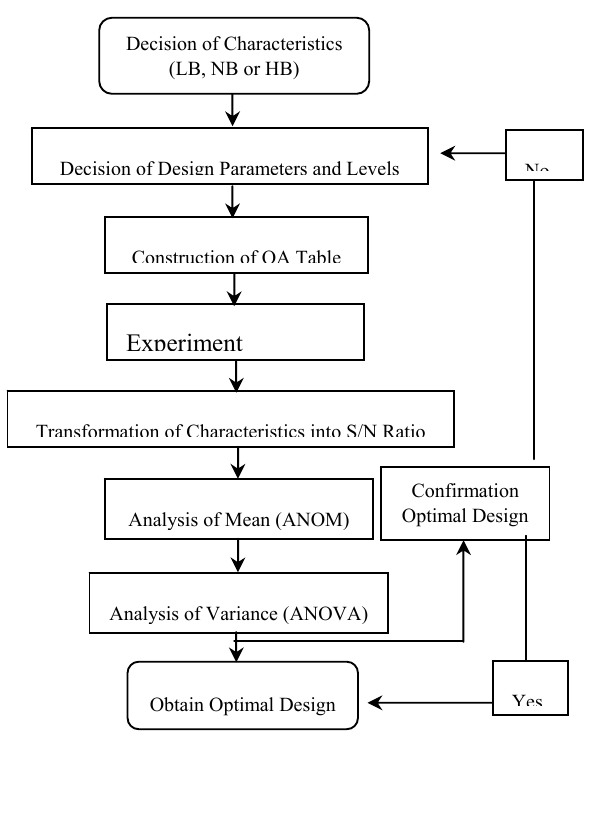
Figure 3. Procedure of Taguchi analysis.